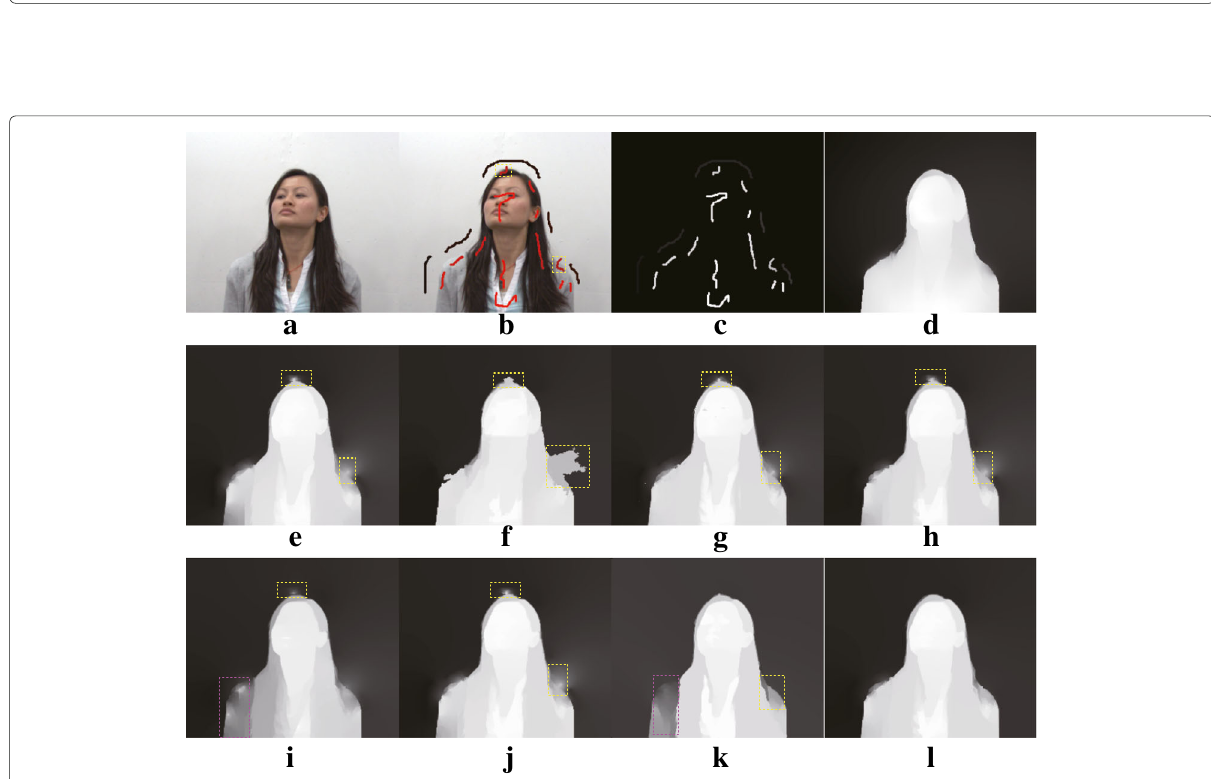
Fig. 7 Results of RGBZ_04 with cross-boundary input. a Input image. b User-labeled image. c Sparse depth. d Groundtruth depth. e Depth of RW. f Depth of HGR. g Depth of NRW. h Depth of OPT. i Depth of OCP. j Depth of SDF. k Depth of (cid:2) 1 . l Depth of the proposed method. Please zoom in to see